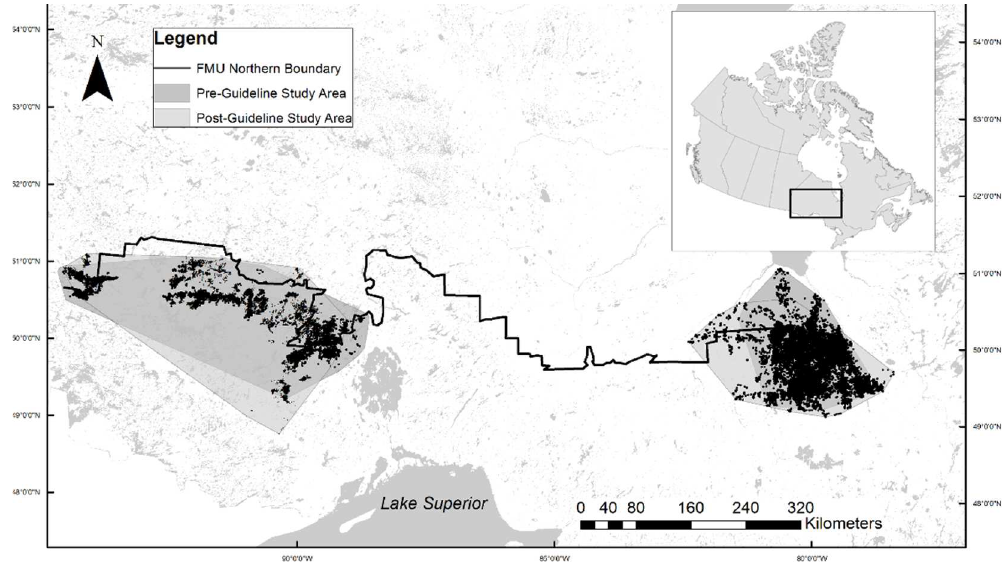
Fig 1. Study Areas. The study areas in eastern and western Ontario, Canadabasedon borealcaribou ( Rangifer tarandus caribou ) radio-locations (black dots) that occurredin early (prior to wide spread caribouhabitat management policy application,1995–2001)and late (followinghabitat management policy application,2009– 2013) time periods. Only caribou who had locationsthat occurredbelow the northern limit of forest management units (FMU) were assessed. Black tick marks represent 1˚ parallelson the y axis and 5˚ meridians on the x